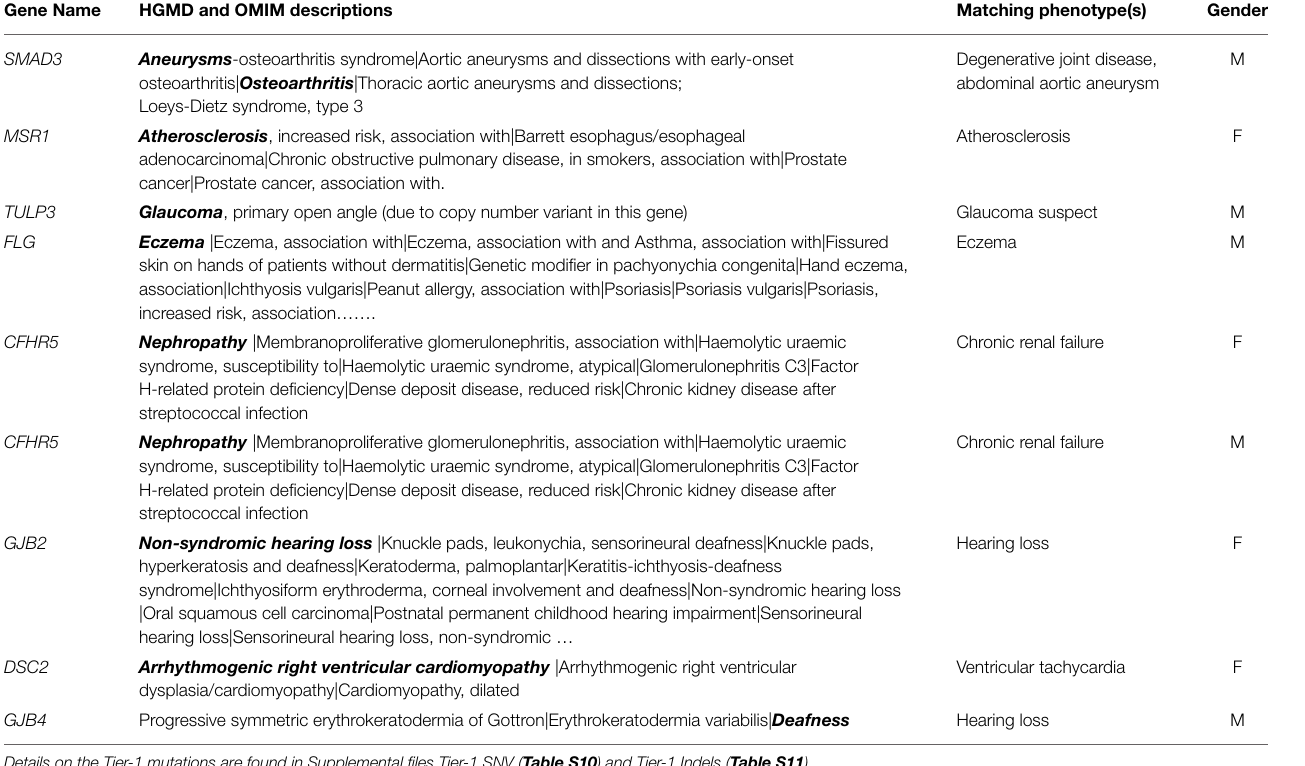
TABLE 3 | AD genes or AD/AR genes with Tier-1 SNV and with Tier-1 INDEL genotypes for which there was a match (shown in bold) with phenotype in a Biobank